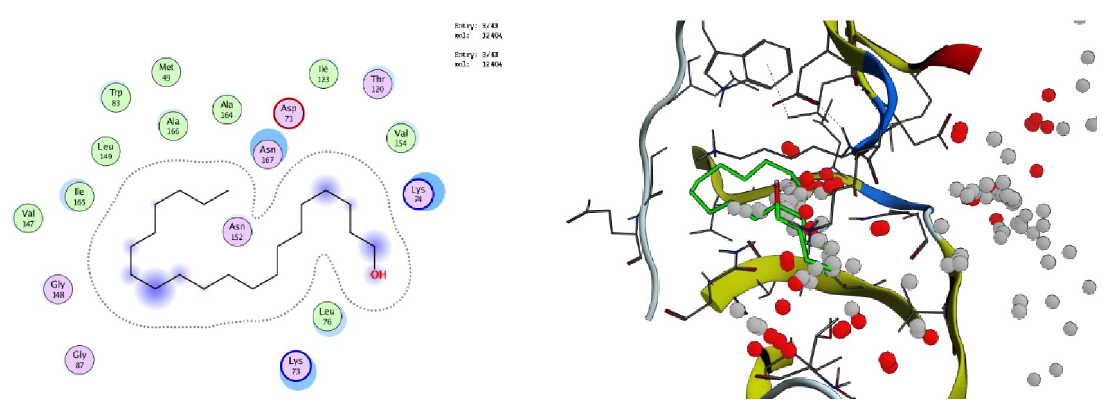
Fig 8. 2D and 3D interaction of compound (3-ethyl-5,5-dimethyl -6-phenyl) with the target protein (PDB ID: